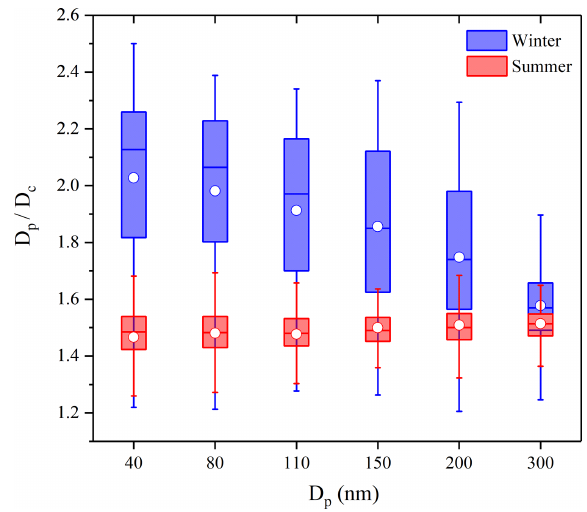
Figure 12. Size-dependent mean D p /D c ratio (circular markers) of fine aerosol particles during the winter (in blue) and summer (in red) periods. The boxes show the 25th, 50th, and 75th percentiles. The extremities show the 5th and 95th